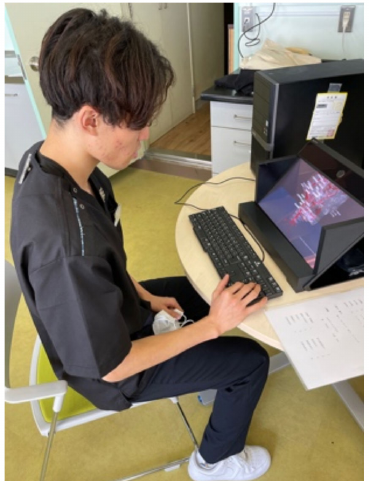
Figure 9. Another example of a dental student experiencing the SRD.